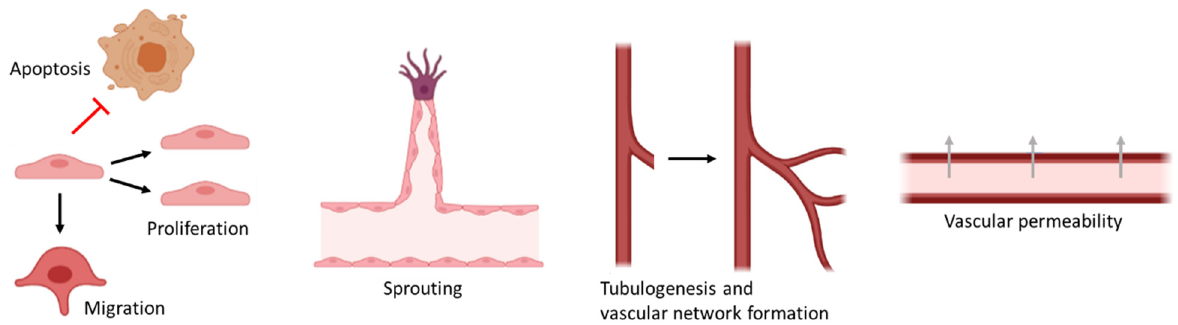
Figure 1. Mechanisms of angiogenesis induced by adipose-derived mesenchymal stem/stromal cells (ASCs). ASCs promote endothelial cell (EC) proliferation and migration while inhibiting apoptosis. Proliferating and migrating ECs form tubular structures, and this initial vascular network is further organized by vessel sprouting, i.e., formation of new vessels from existing ones in response to angiogenic stimuli. In mature blood vessels, ASCs regulate vascular permeability. Figure created using